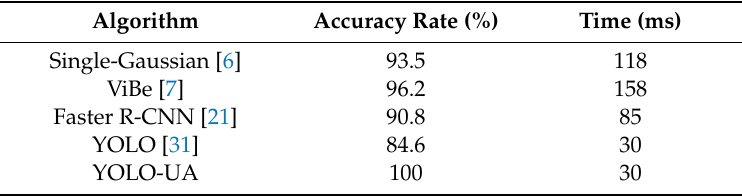
Table 7. Di ff erent algorithms used for tra ffi c